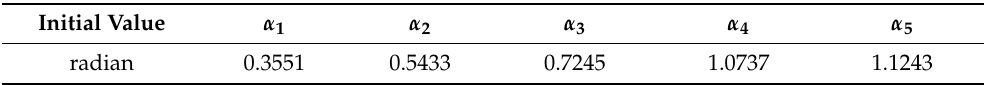
Table 1. Actual parameters of PM position. Initial Value